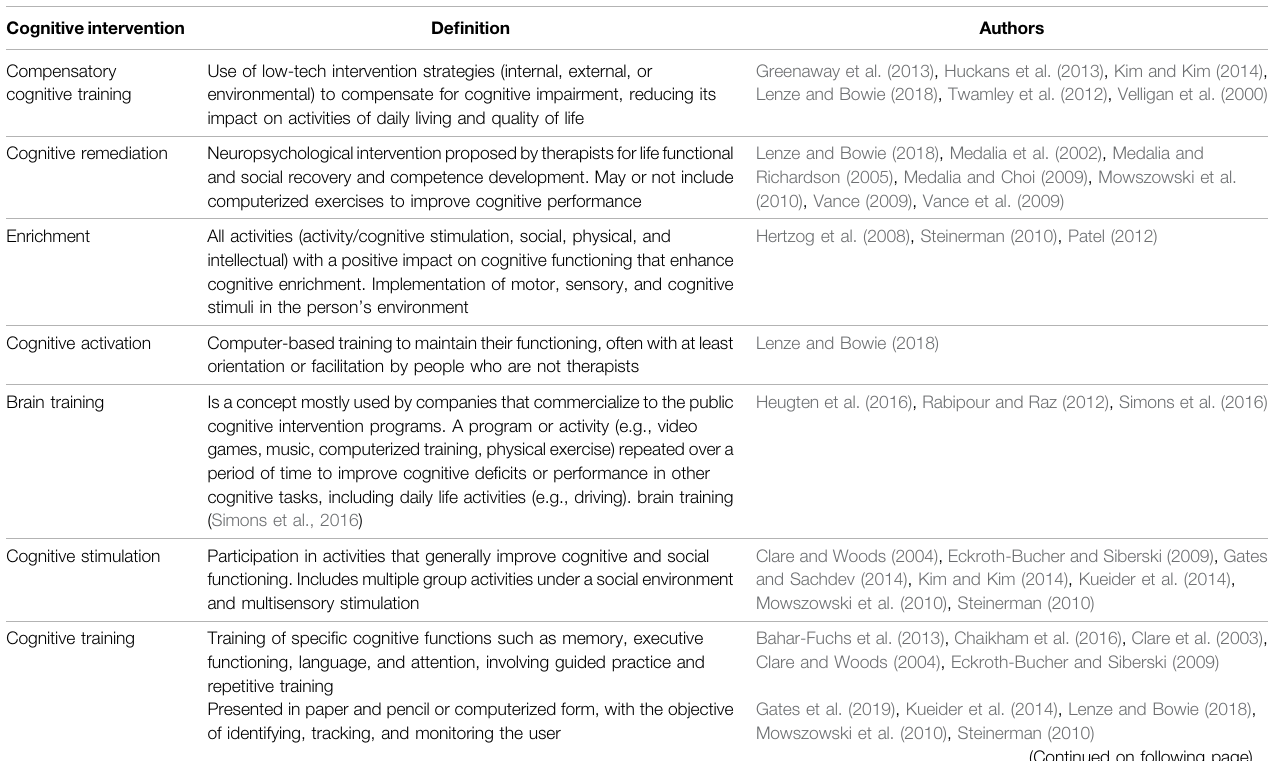
TABLE 1 | Types of cognitive intervention de fi ned in the